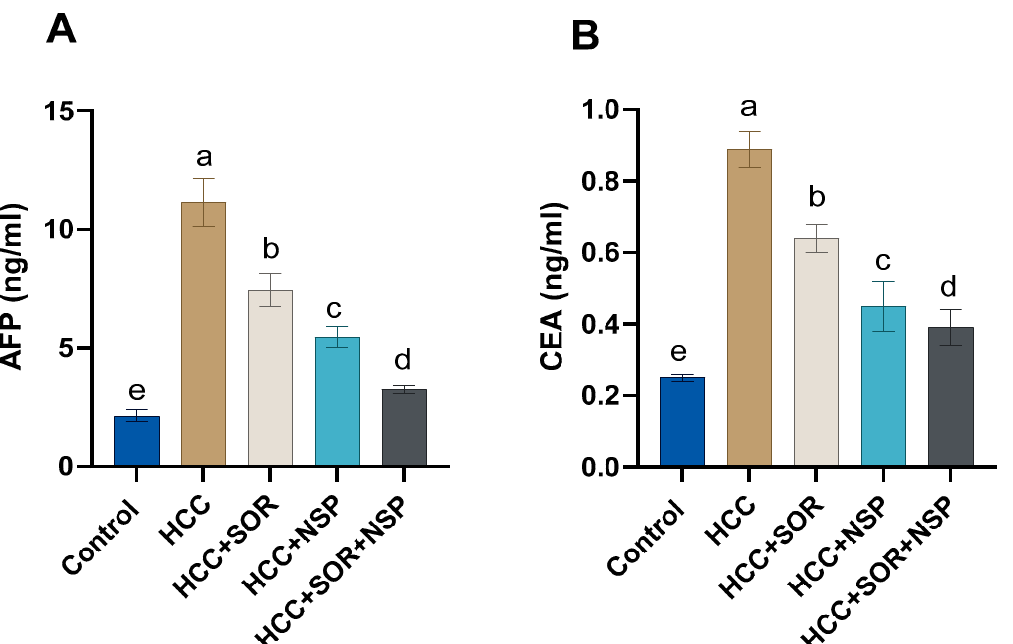
Figure 2. Effects of SOR, NSP, and their combination in DENA-induced HCC on the antioxidant status. ( A ) AFP; ( B ) CEA. Data are presented as the mean ± SE. a, b, c, d Mean values with different letters differ significantly at ( p ≤ 0.05). ( n = 8).